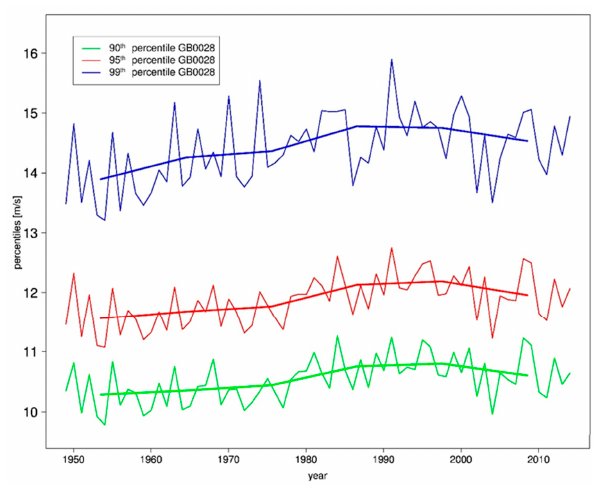
Figure 6. Time series of annual 90th (green), 95th (red) and 99th (blue) percentile of 10 m wind speed of the GB0028 domain mean. The 10-year running mean lines are added. Atmosphere 2019 , 10 , x FOR PEER REVIEW